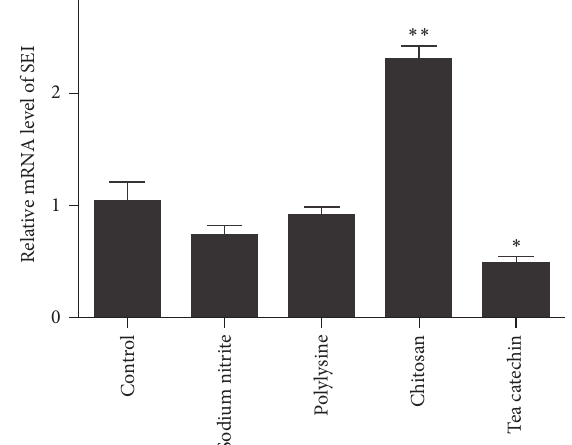
Figure 2: Effect of different food preservatives on sei gene tran- scription. S. aureus H4 was treated with sodium nitrite, polylysine, chitosan, or tea catechin, respectively, as described above. At the 24th-hour incubation, S. aureus were lysed by lysozyme and the mRNA was detected by real time quantitative PCR. Data were the mean ± SEM of three independent experiments ( ∗ 𝑝 < 0.05 , ∗∗ 𝑝 < 0.01